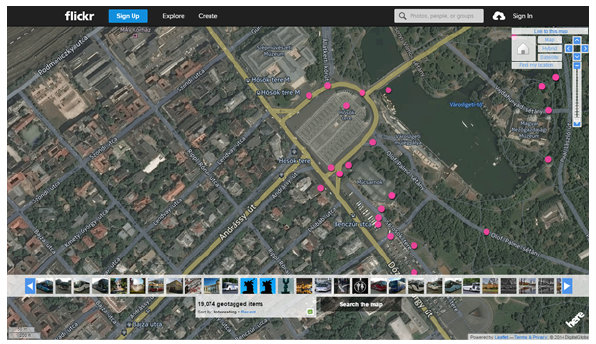
Figure 1. The Flickr map query to study the available uploaded